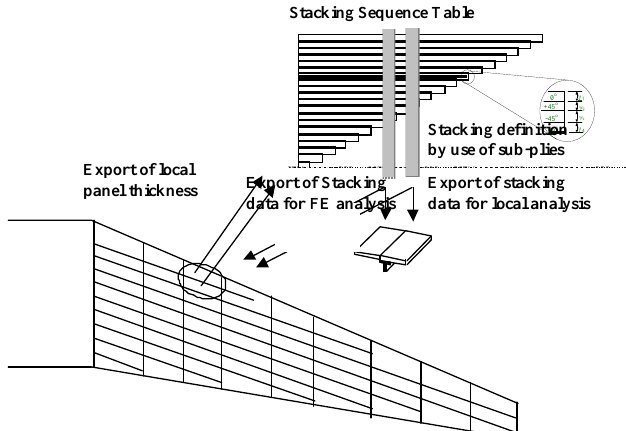
Fig. 21: Continuous approach to composite